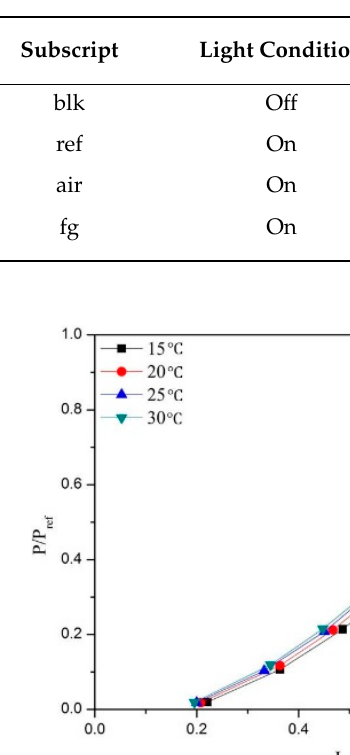
Table 1. Images required for the pressure sensitive paint (PSP) technique.